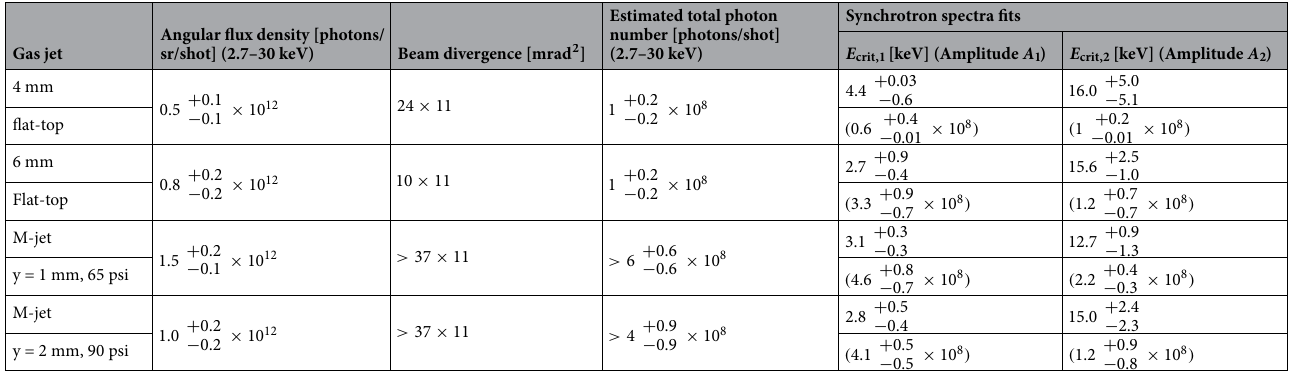
Table 1. Gas jet comparison. The angular flux density is averaged over 5 shots for each jet. The total number of photons is estimated from the angular flux density and the beam divergence. As the X-ray beam divergence exceeds the detector solid angle, the horizontal X-ray beam divergence is inferred from the electron beam divergence and the vertical divergence from the angular acceptance of the CCD detector (11 mrad). The averaged critical energies E crit, i and amplitudes A i for each jet are obtained by fitting an N = 2 sum of synchrotron spectra (Eq. 3) to the 5-shot averaged spectra. The uncertainties are obtained by fitting a similar term to the 5-shot confidence